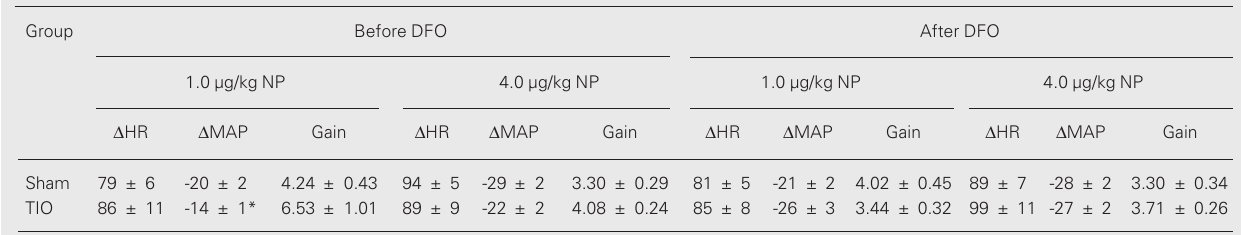
4.08 ± 0.24 85 ± 8 -26 ± 3 3.44 ± 0.32 99 ± 11 -27 ± 2 3.71 ± 0.26 Data are reported as means ± SEM for 7 rats in each group. HR = heart rate; MAP = mean arterial pressure; DFO = deferoxamine mesylate; NP = sodium nitroprusside; TIO = tissue iron overload. *P < 0.01 compared to the sham group (Student t